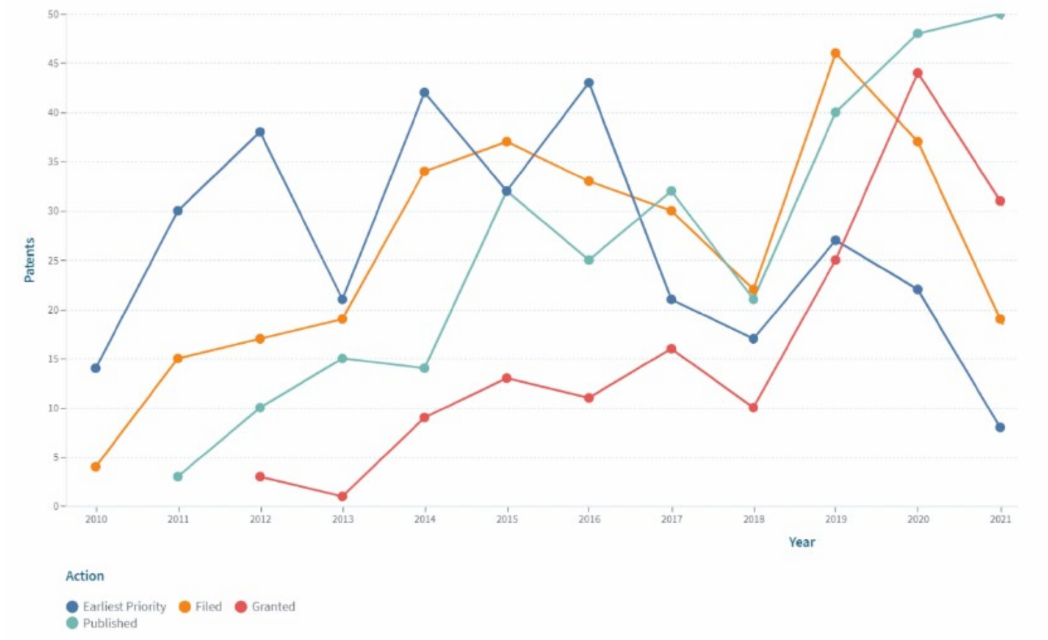
Figure 9. The number of patents over